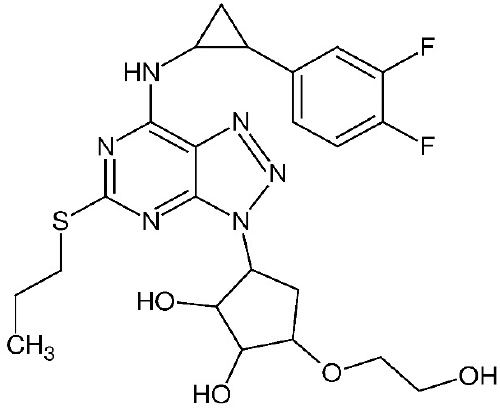
Figure 1. Chemical structure of ticagrelor.